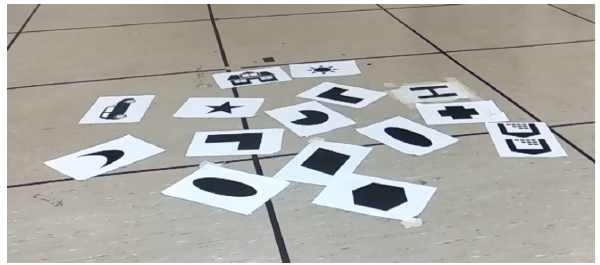
Figure 5. Scene used for the BW Planar